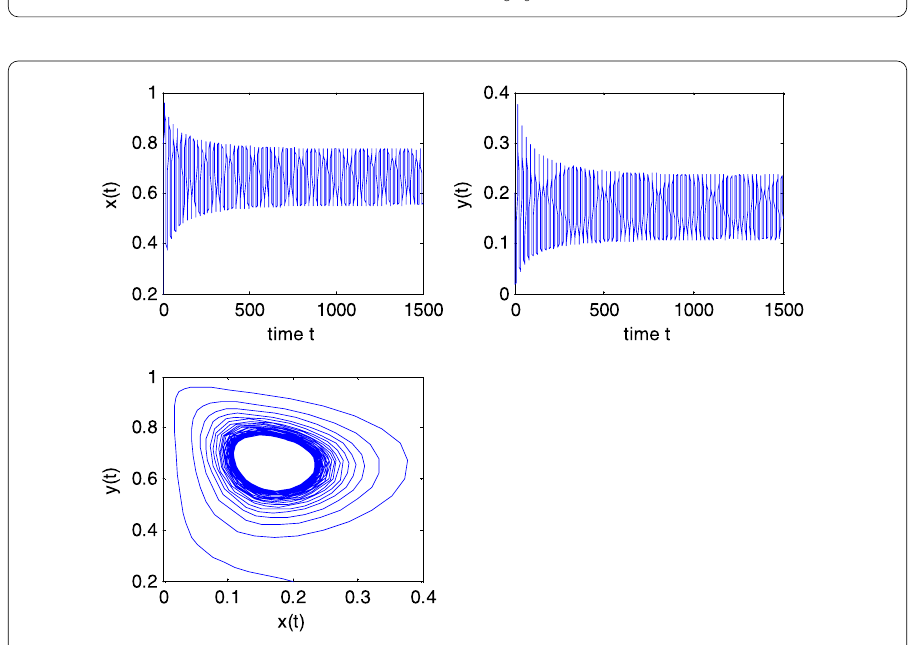
Figure 1 Behavior and phase portrait of an uncontrolled system (1.2) with τ 1 = 0, τ 2 = 3.7 > τ 0 bifurcation occurs from the positive equilibrium E ∗ ( x 0 , y 0 ) = ( 2